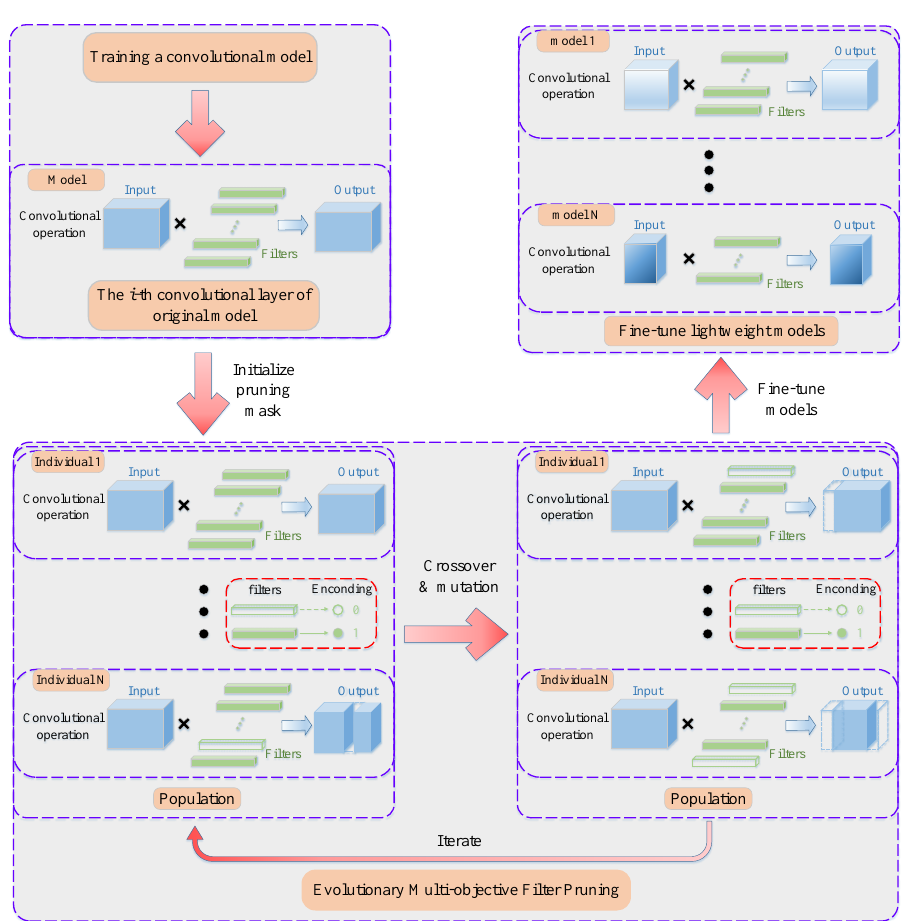
Figure 1. The framework of evolutionary multi-objective one-shot filter